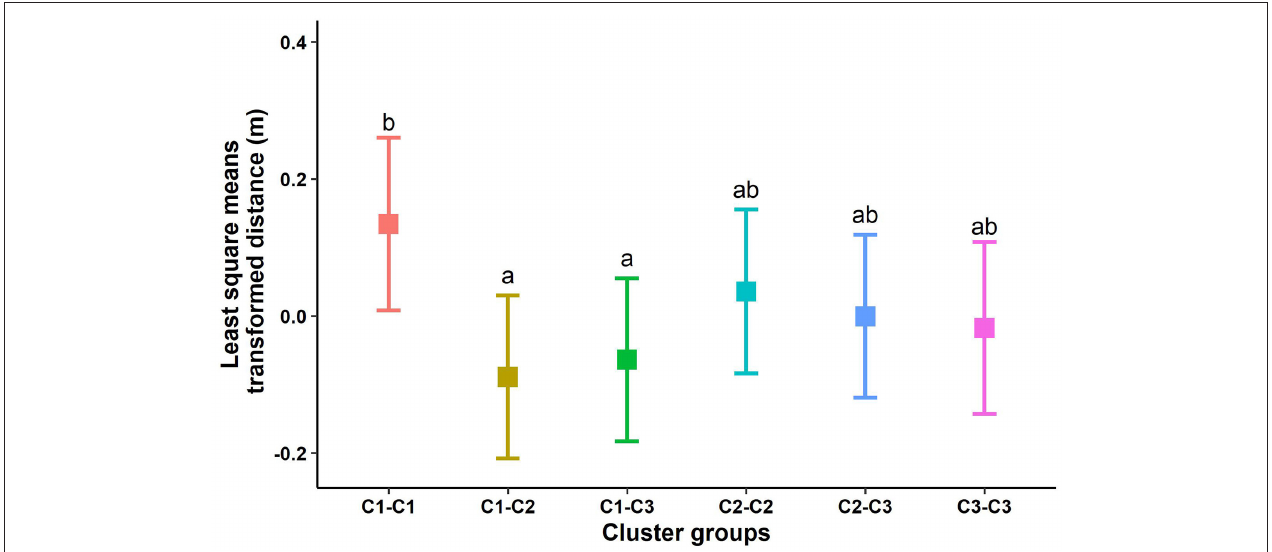
FIGURE 4 | Box plot of the distance between animals with different personality traits with a threshold distance of up to 2m. Dissimilar letters indicate significant differences based on a Tukey test with α at 0.05. C1, cluster 1 (bold animals); C2, cluster 2 (fearful animals); and C3, cluster 3 [bold toward a novel object but fearful of a human (bold/fearful)].